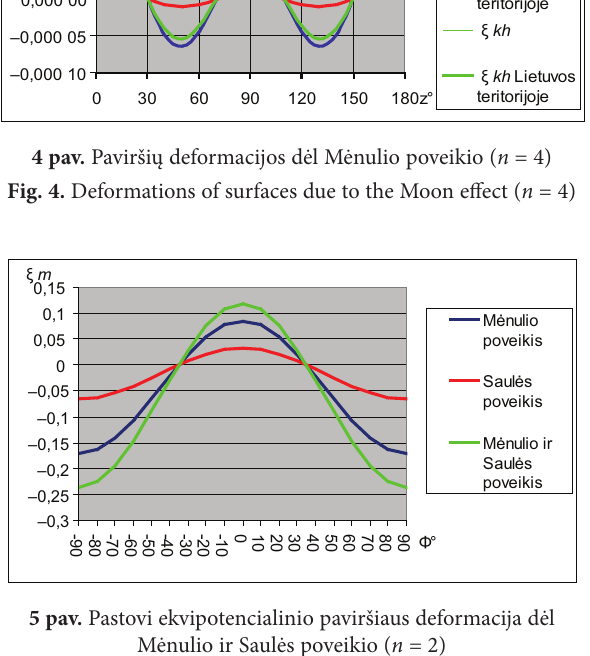
5 pav. Pastovi ekvipotencialinio paviršiaus deformacija dėl Fig. 5. Permanent deformation of equipotential surface due to effect of the Sun and Moon ( n =